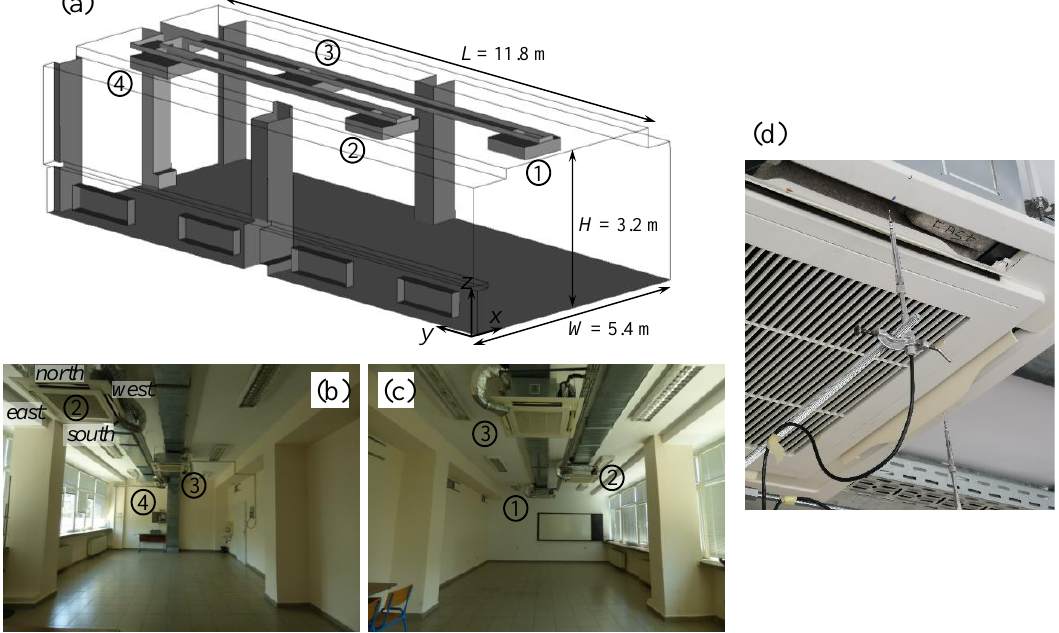
Figure 1. ( a ) Geometry model for Unsteady RANS (URANS), ( b , c ) room interior photos with four fan coils numbered, ( d ) photo near a fan coil.